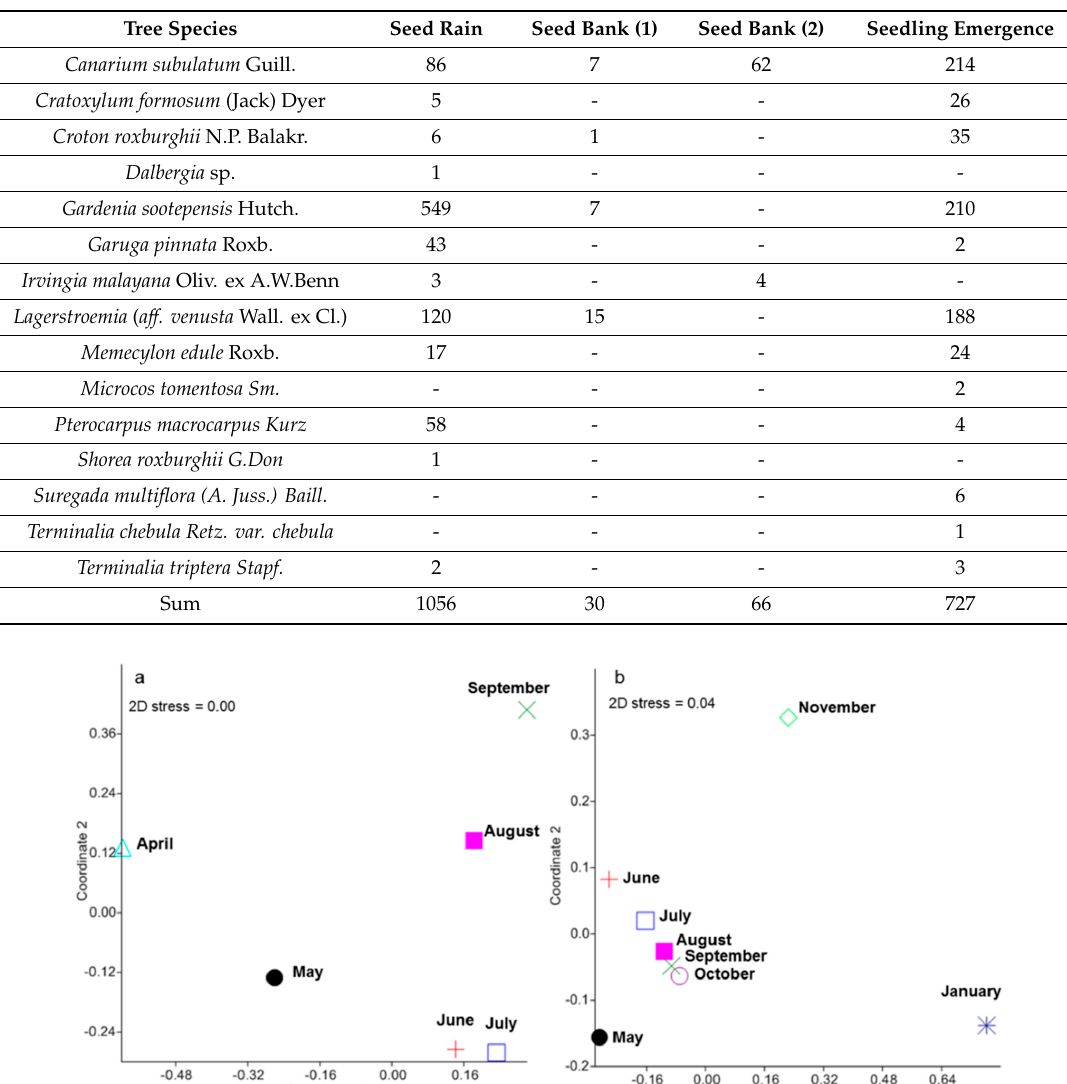
Table 1. Abundances of tree seeds or seedlings obtained from three different methods: seed rain, soil seed bank (two repetitions), and seedling emergence. Two varieties of Aporosa octandra were treated as two different species in this study. Tree Species Seed Rain Seed Bank (1) Seed Bank (2) Seedling Emergence Aporosa octandra (B.-H. ex D.Don) Vick. var. octandra